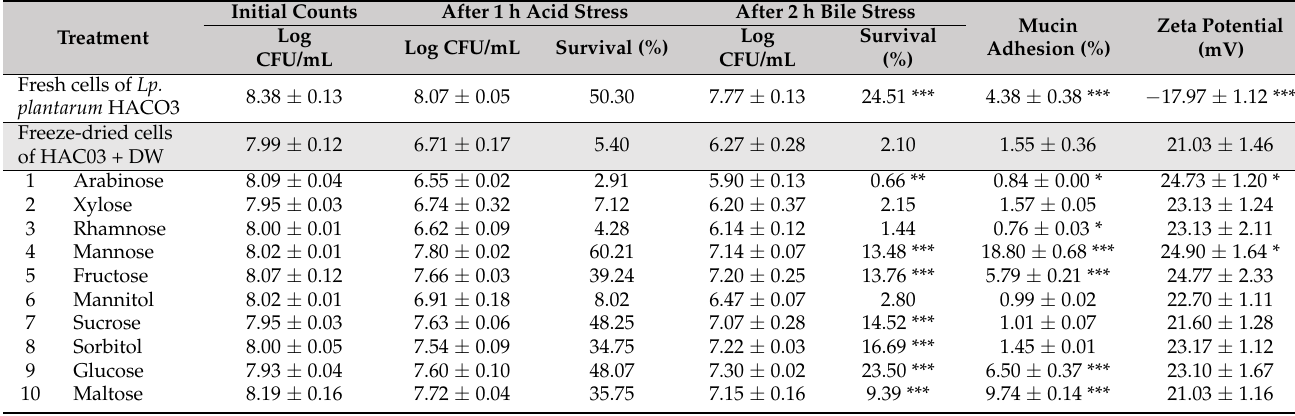
Table 2. Effect of rehydration with different food additives on the viability, zeta potential and mucin adhesion of freeze-dried Lp. plantarum HAC03 after subjection to simulated GIT